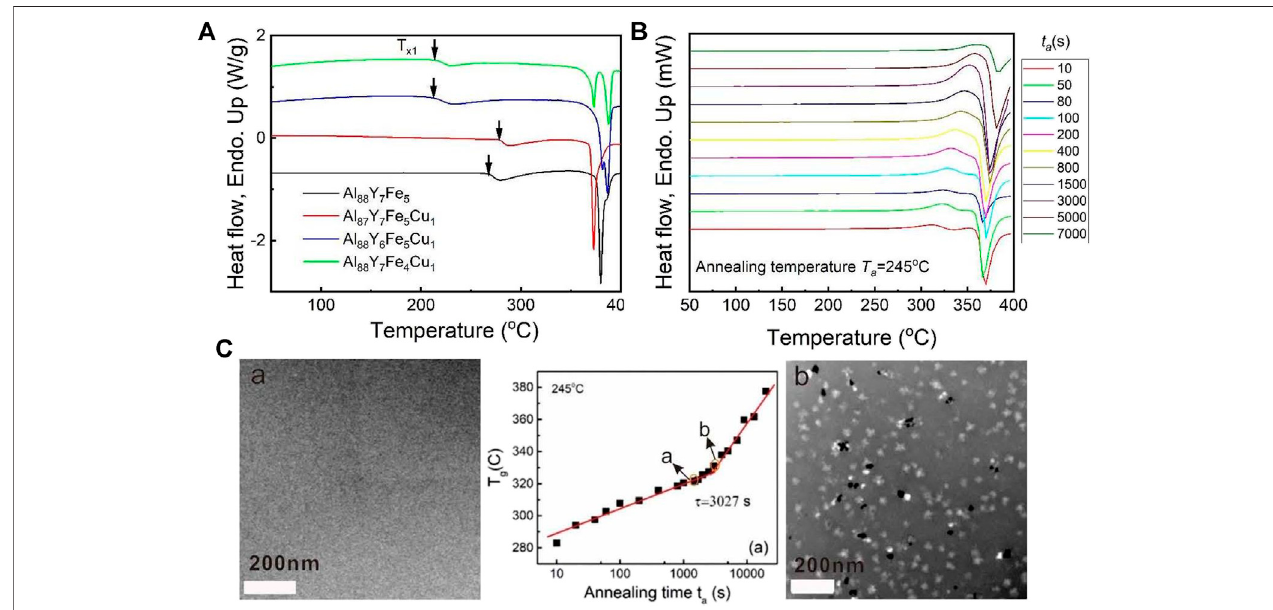
FIGURE6|(A) ConventionalDSCheat fl owcurvesfor1%Cu-dopedAl-Y-FeMGsystemsundertheheatingrateof0.33 K/s. (B) FlashDSCheat fl owcurveswitha seriesof annealingtimesta from 10 to 7,000 s at 245 ° C for the comosition of Al 87 Y 7 Fe 5 Cu 1 under the heating rate of 1000 K/s. (C) (Middle plot) The plot of Tg and logta for Al 87 Y 7 Fe 5 Cu 1 at 245 ° C. TEM images were taken from a series of annealed Al 87 Y 7 Fe 5 Cu 1 samples when the annelaing time is smaller (2,000 s corresponding to picture of (A) and larger (4,000 s corresponding to picture of (B) ) than the experimental delay time of 3,027 s. (from Gao et al. (2019)).